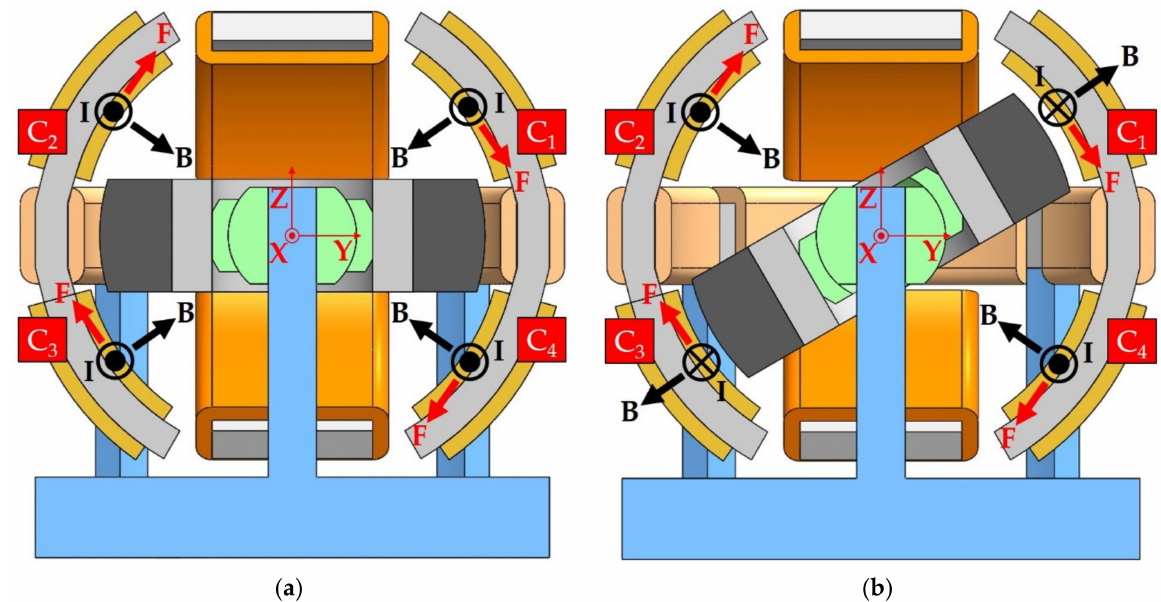
Figure 3. The operating principle for the rotation about the X -axis when the rotor is tilted at ( a ) 0 ◦ and ( b ) 30 ◦ along the X -axis.